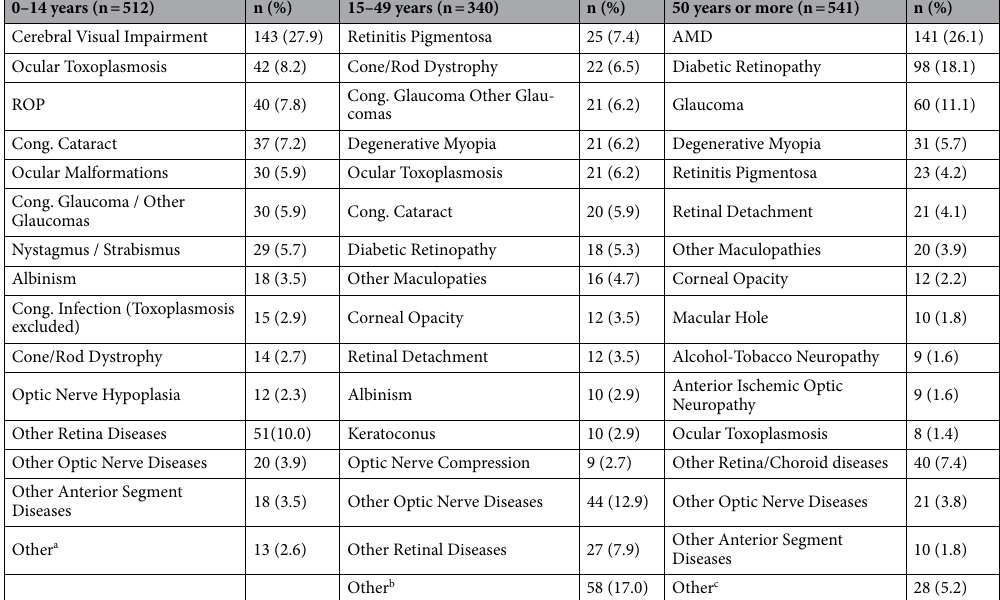
Table 3. Causes of functional low vision divided per age group (n = 1393). AMD Aged-Related Macular Disease, ROP Retinopathy of Prematurity, Cong Congenital. a Low vision with no defined etiology (6); acquired central nervous system infection (6); chronic uveitis associated with juvenile idiopathic arthritis (1). b Low vision with no defined etiology (12); nystagmus (8) ocular malformation (8); central nervous system infection (7); central nervous system stroke (5); cerebellar ataxia (5); traumatic brain injury (4); amblyopia due to high ametropia (2); acquired choroidopathy (3); ocular trauma (3), cerebral palsy (2); ocular tumor (1); sympathetic ophthalmia (1). c Low vision with no defined etiology (9); central nervous system stroke (7); ocular trauma (4); uveitis with no defined etiology (2); traumatic brain injury (2); amblyopia due to high ametropia (1); ischemic ocular syndrome (1); congenital infection (1); ocular malformation (1).